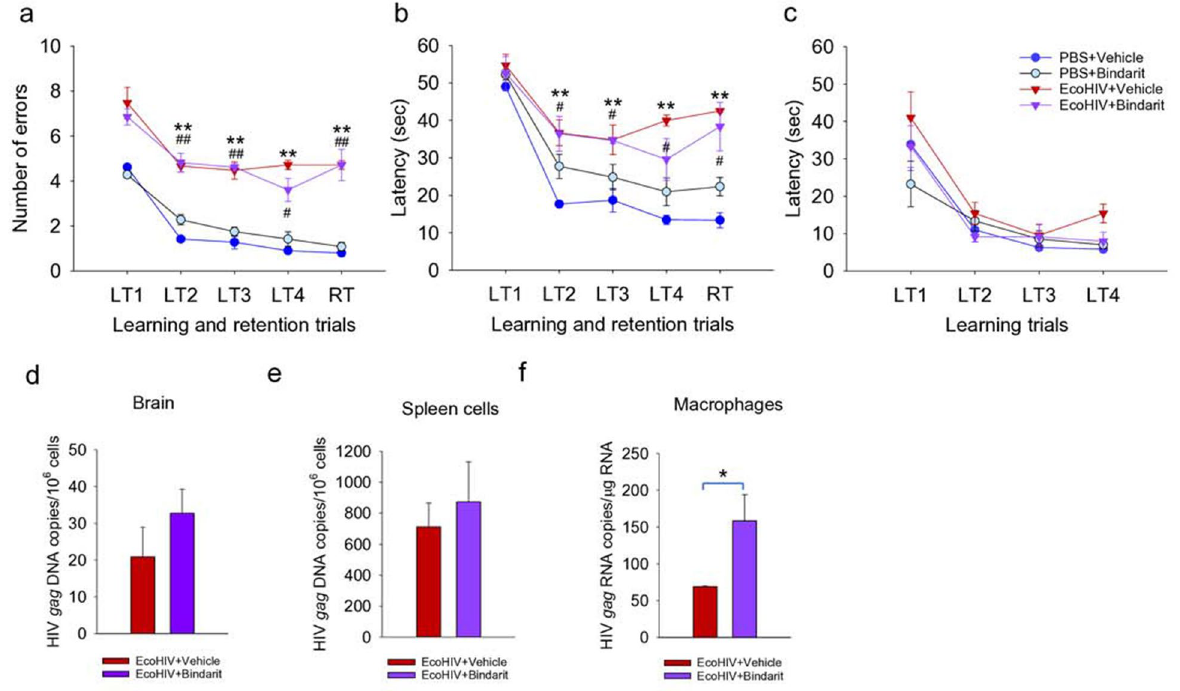
Figure 5. Inhibition of CCL2 driven monocyte/macrophage migration in chronically infected mice does not affect established EcoHIV induced learning/memory defects. Four weeks after EcoHIV infection of male 6–8-week-old C57BL/6 mice, the animals were treated daily with bindarit for 2 weeks prior to behavioral test and euthanasia. RAWM was conducted by measurement of ( a ) errors and ( b ) time to find the hidden platform or ( c ) time to find the visible platform; n = 17 per group. RM ANOVA: ( a ) F(3,80) = 41.265, p < 0.001/ LT2, F(3,80) = 36.379, p < 0.001/LT3, F(3,80) = 47.972, p < 0.001/LT4; ( b ) F(3,80) = 34.142, p < 0.001/LT2, F(3,80) = 25.528, p < 0.001/LT3, F(3,80) = 37.372, p < 0.001/LT4; For RT values, see text. Pairwise t-test, **p < 0.01 PBS + vehicle and PBS + bindarit vs. EcoHIV + vehicle, # p < 0.05 and ## p < 0.01 PBS + bindarit versus EcoHIV + bindarit. ( d , e ) HIV gag DNA was measured in ( d ) brain and ( e ) spleen cells, or ( f ) HIV gag RNA was measured in peritoneal macrophages. *p < 0.05 EcoHIV + vehicle vs. EcoHIV +